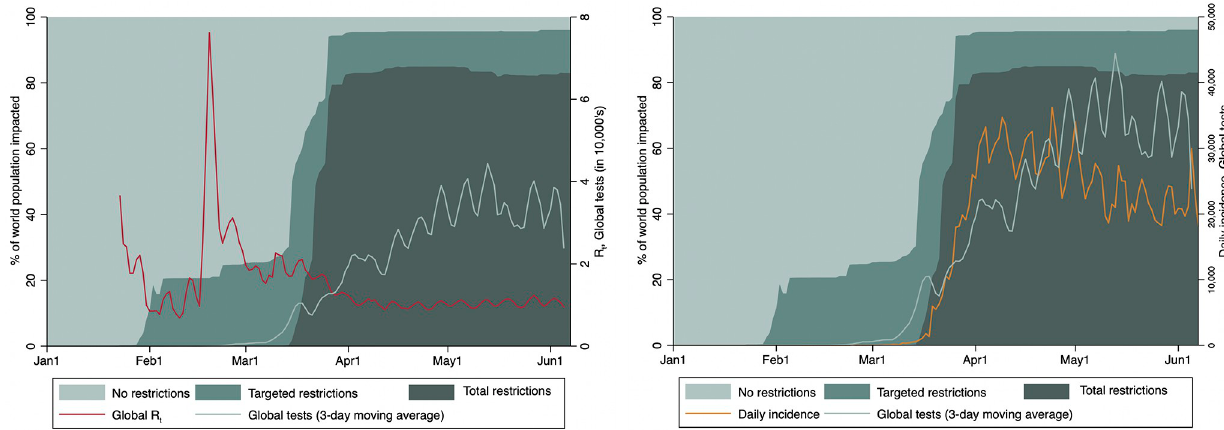
Fig 1. Global border closures and changes in COVID-19 R t and incidence. Stacked area plot of the world’s population living in countries with no border closures, targeted border closures, and total border closures. From left to right are the time-series trends of: i) global time-varying effective reproductive number (R t ) and number of global diagnostic tests; and ii) daily incidence and number of global diagnostic